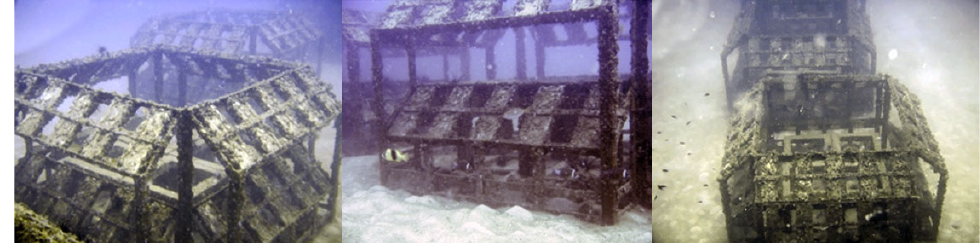
Figure 7. Underwater photo of BK AR modules at different angles at Tukun Telaga Batin.